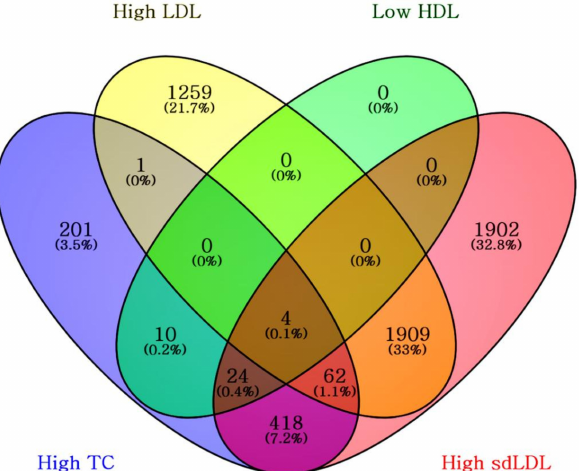
Figure 4. Venn diagram for the 5790 subjects having major risk factors for coronary heart disease; high total cholesterol (TC) ≥ 240 mg/dL, high LDL ≥ 160 mg/dL, low HDL < 40 mg/dL, and phenotype non-A predominant small dense LDL (sdLDL) with a mean LDL particle size < 268